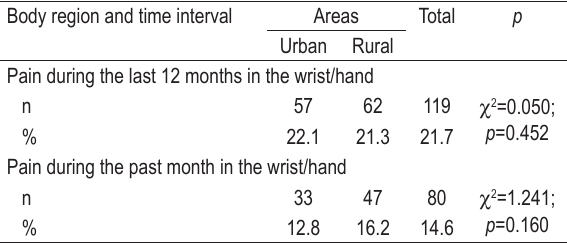
TABLE 6. The presence of pain in the wrist/hand Body region and time interval Areas